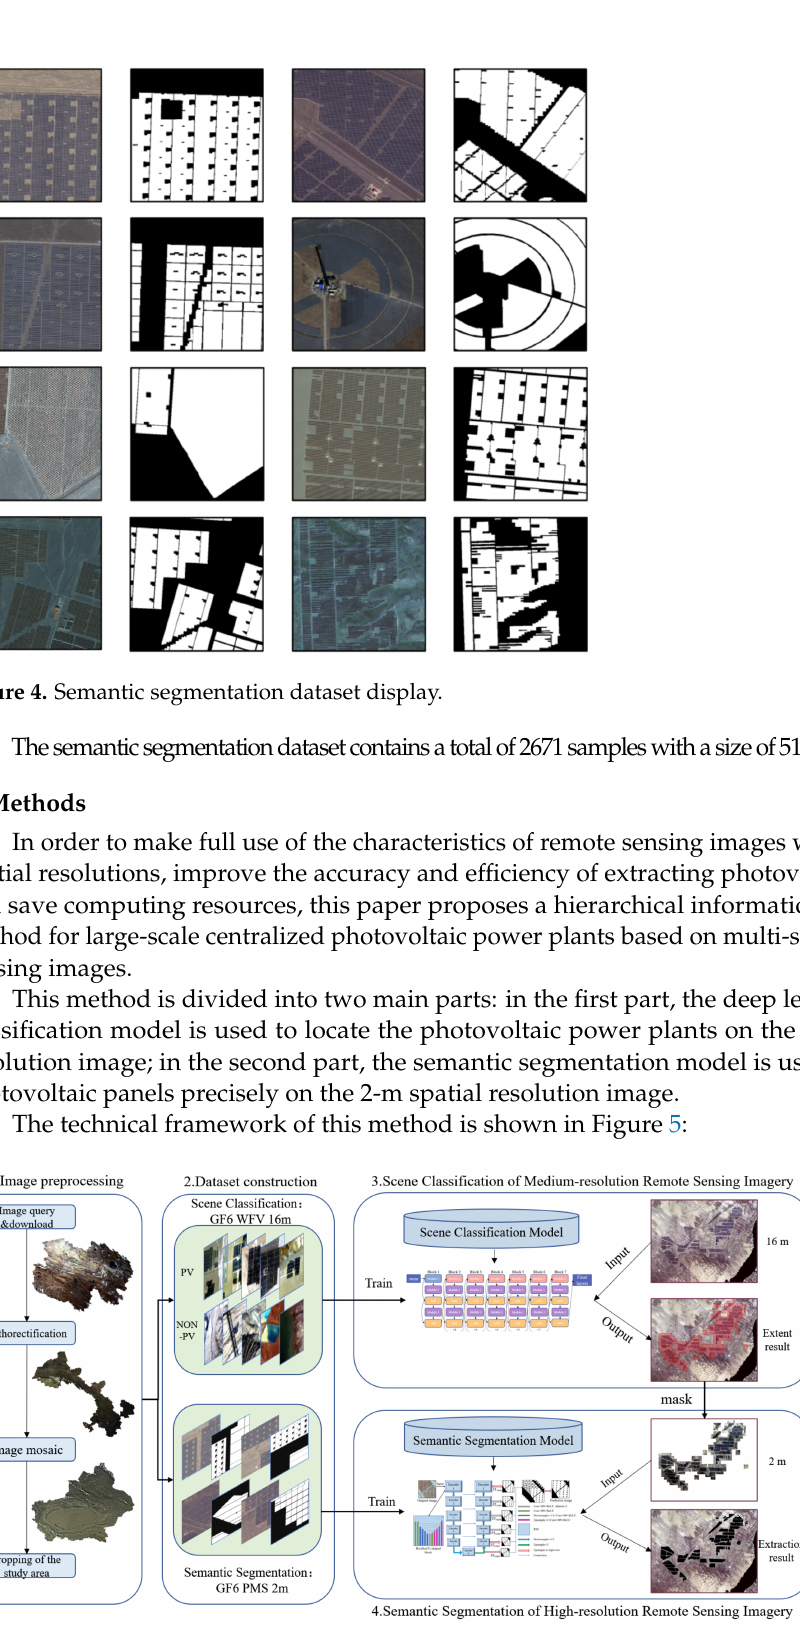
Figure 5. Framework for hierarchical information extraction of large-scale centralized photovoltaic power